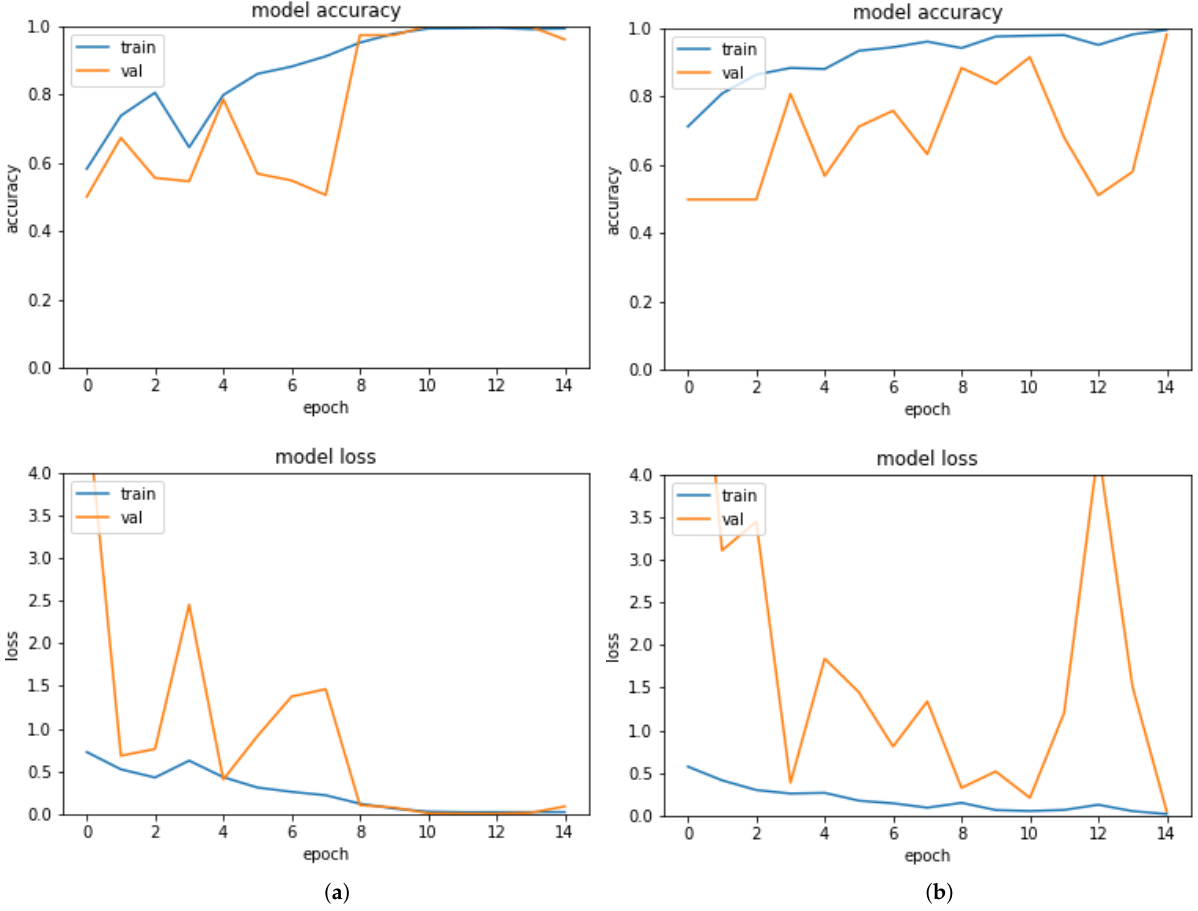
Figure 9. Training curve of datasets analysed on InceptionResNet-V2 with Google Colab. ( a ) Sea dataset; ( b ) paintings